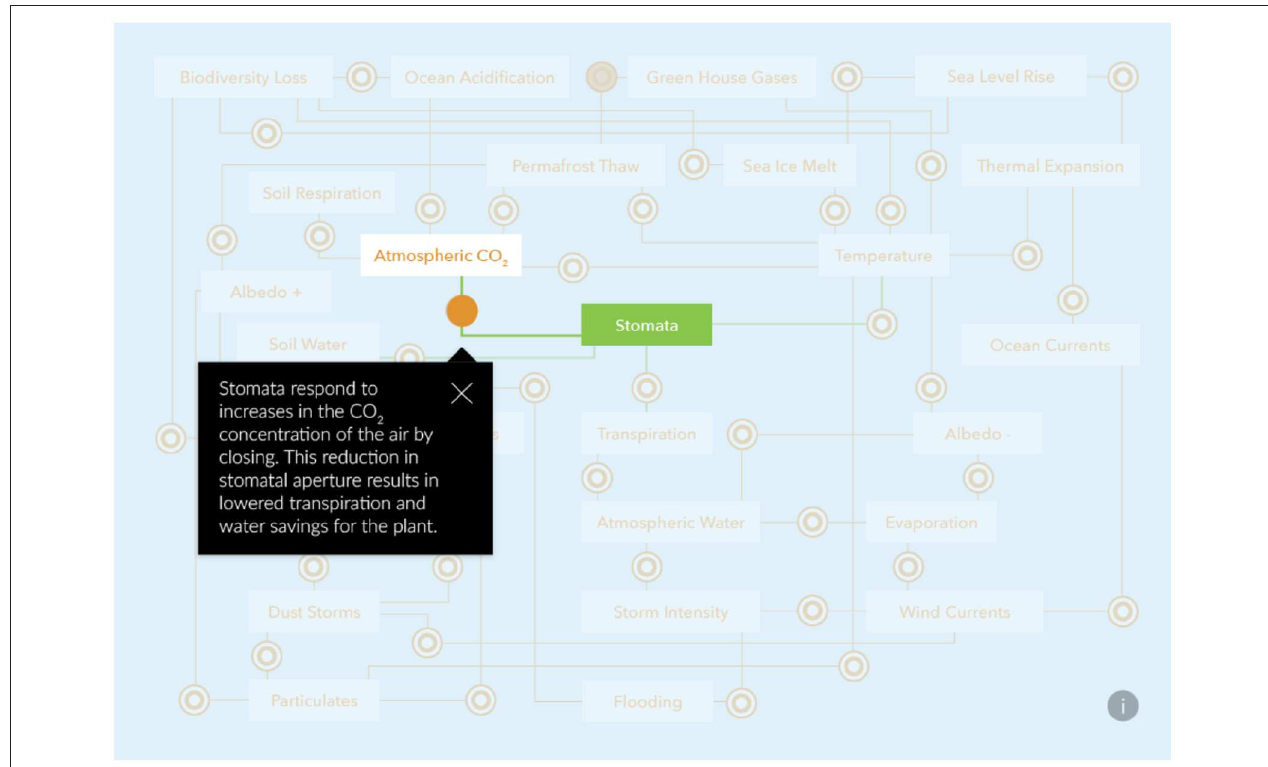
FIGURE 3 | Screenshot of the “connections” page of the app. The user can navigate through the many connections between the environment and parameters affected by humans. Some information boxes contain links to external